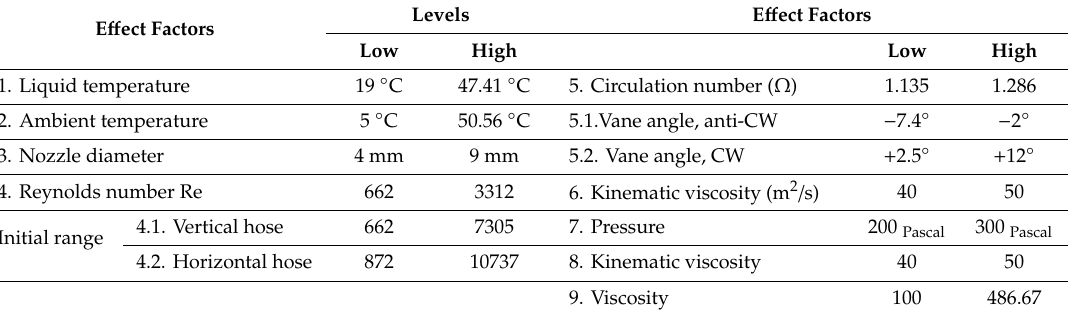
Table 1. The e ff ect factors in the deep-lean painting